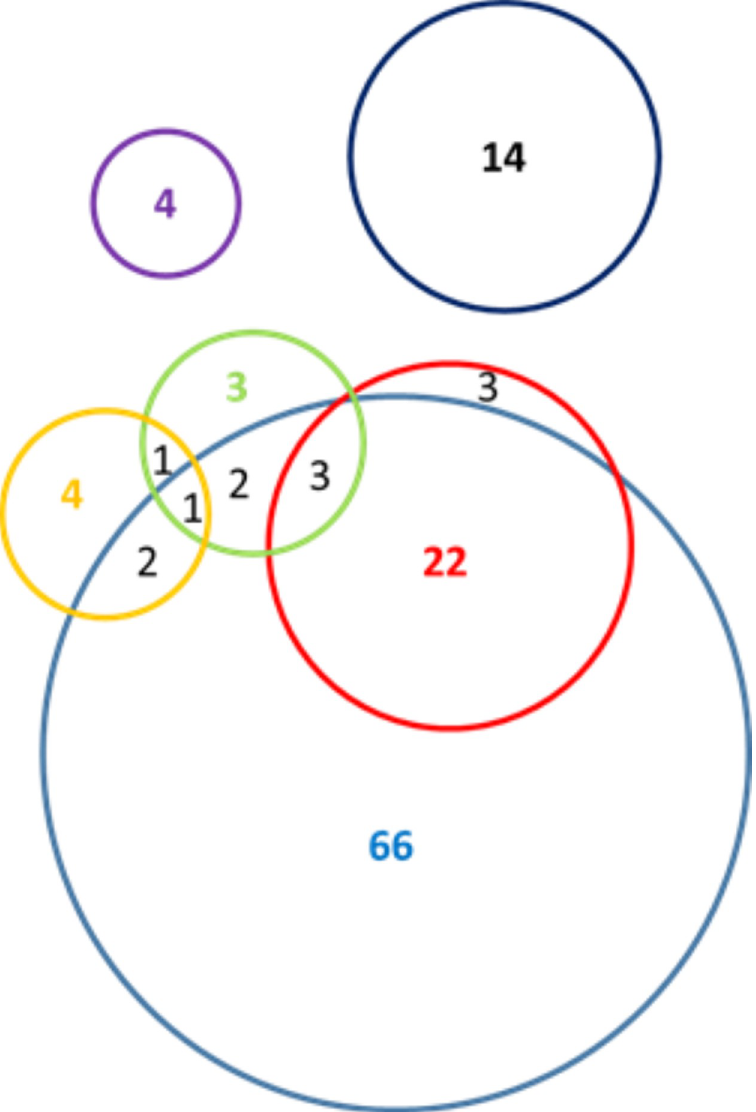
Fig 1. Venn diagram of risk factors among tested individuals (n = 125). PWID (n = 96)—blue, MSM (n = 10)— green, Incarceration (n = 28)—red, Blood transfusion (n = 4)—purple, Sex Workers (n = 8)—yellow, No reported risk (n =